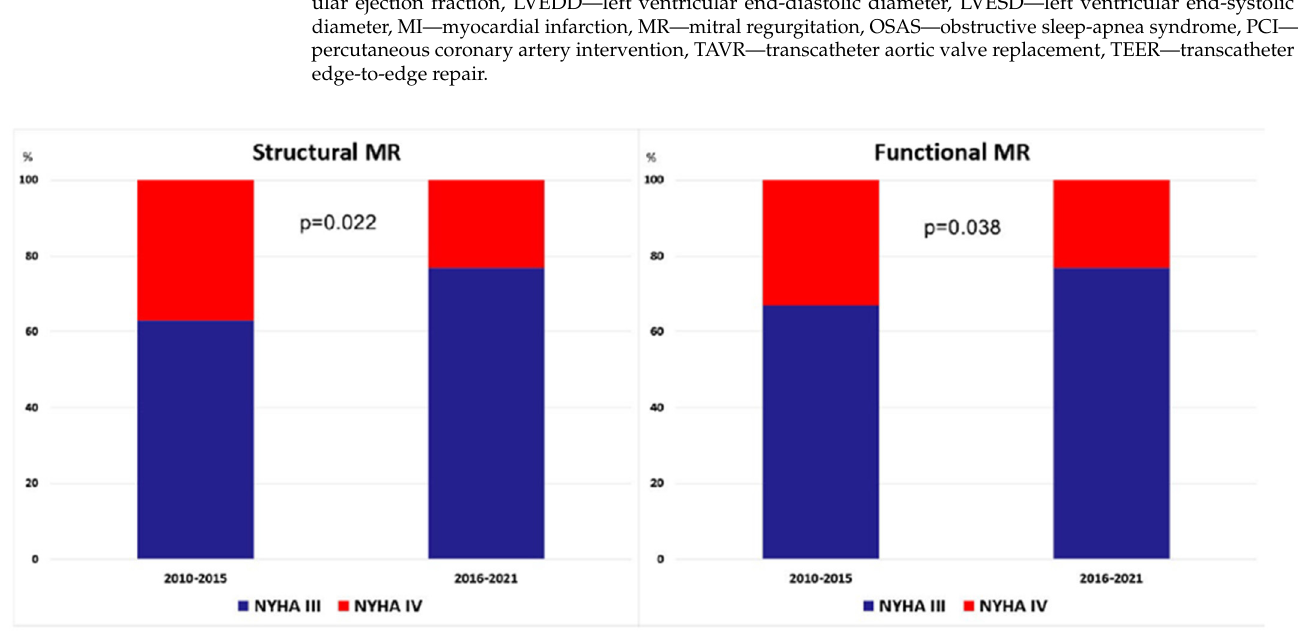
Figure 4. The difference in prevalence of patients with New York Heart Association (NYHA)